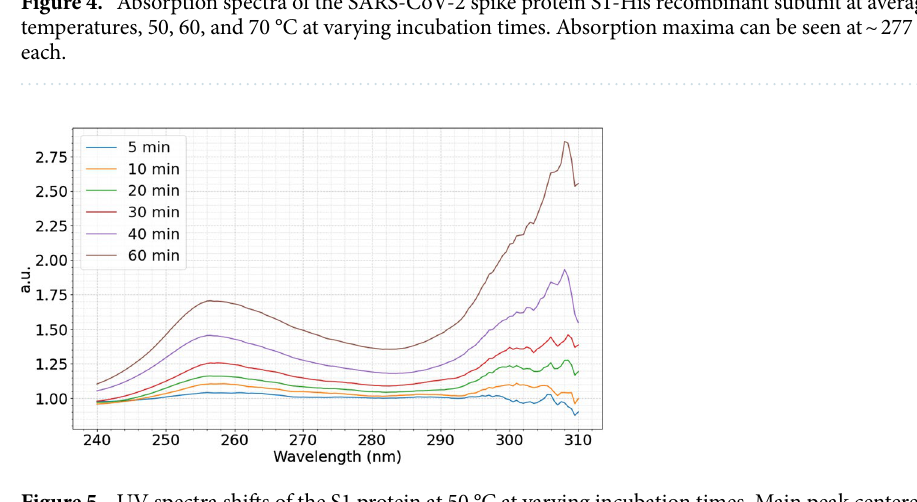
Figure 5. UV spectra shifts of the S1 protein at 50 °C at varying incubation times. Main peak centered at ~ 256.5